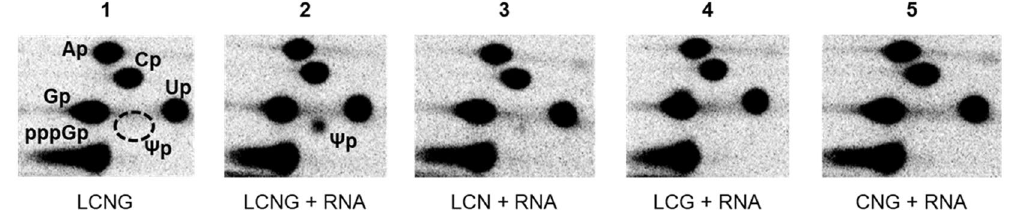
Figure 5. In vitro activity tests suggesting that Cbf5 ′ s RNA dependent activity modifies orphan position U 2589(2585) . The mini–23S–2589 RNA fragment was radiolabeled by incorporation of [ α - 32 P]GTP during in vitro transcription. This substrate was incubated with different combination of the four recombinant proteins from T . kodakarensis L7Ae (L), Cbf5 (C), Nop10 (N), and Gar1 (G) and total RNAs extracted from a S100 fraction from KU216 cells ( + RNA). After digestion with RNase T2, the amount of Ψ formation was estimated by two- dimension thin layer chromatography as described in Methods. The control reaction (panel 1) was performed in the presence of LCNG but without the addition of total RNAs. The plates corresponding to each panel were exposed together on a same screen of the PhosphorImager. The full-length image is presented in Supplementary Figure